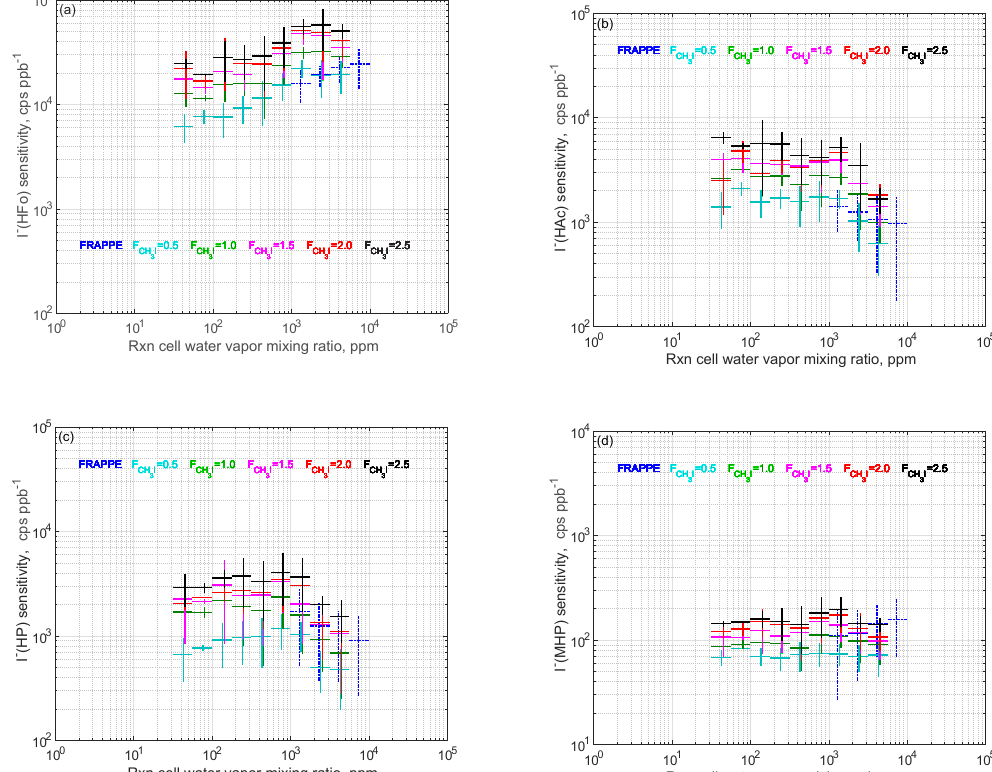
Figure 3. Laboratory calibration sensitivities (cpsppb − 1 ) for five CH 3 I flow rates (0.5–2.0sccm) and FRAPPÉ in-flight calibration sensitivi- ties as a function of reaction cell water vapor mixing ratio (ppm) for (a) I − ( HFo ) at m/z 173, (b) I − HAc at m/z 187, (c) I − ( HP ) at m/z 161, and (d) I − ( MHP ) at m/z 175. Note the scale difference for (d) . The horizontal bar represents the limits of the reaction cell water vapor mixing ratio bin and the mean sensitivity of that bin is plotted. The length of the vertical bar represents 1 SD and the variability represents random variations in pressure, ambient concentrations during the standard addition, and systematic variations due to water vapor in a bin, calibration gas precision, and instrumental